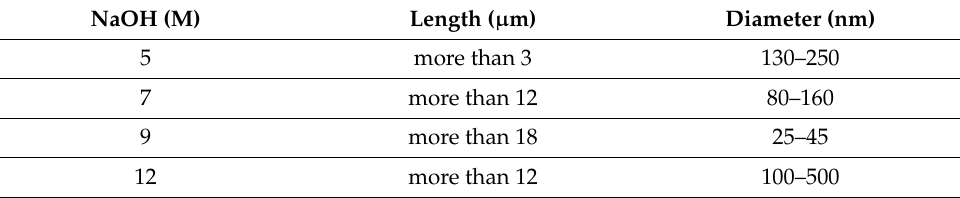
Table 4. Dimensions of copper nanowires synthesized under the various concentrations of